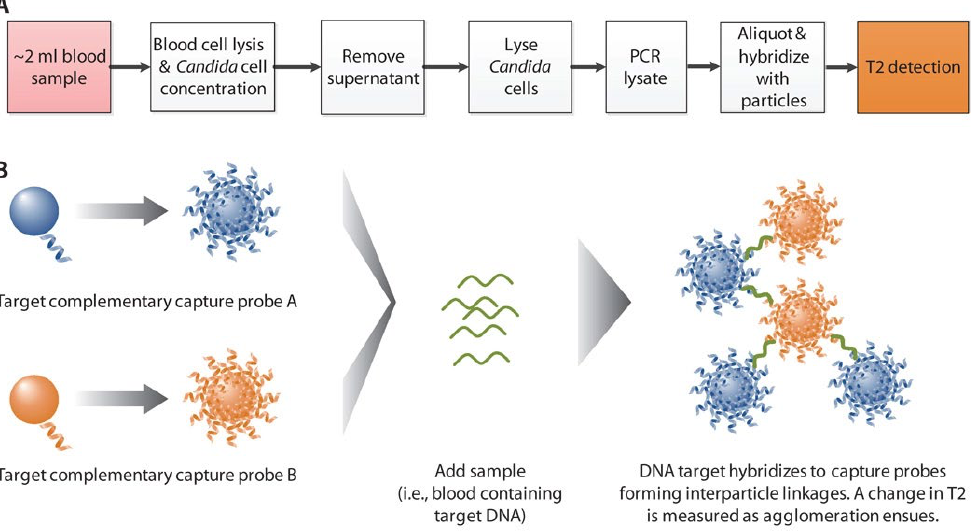
Figure 3. ( A ) Candida T2MR assay process. ( B ) T2MR detecting particle reagent schematic. SPIONs